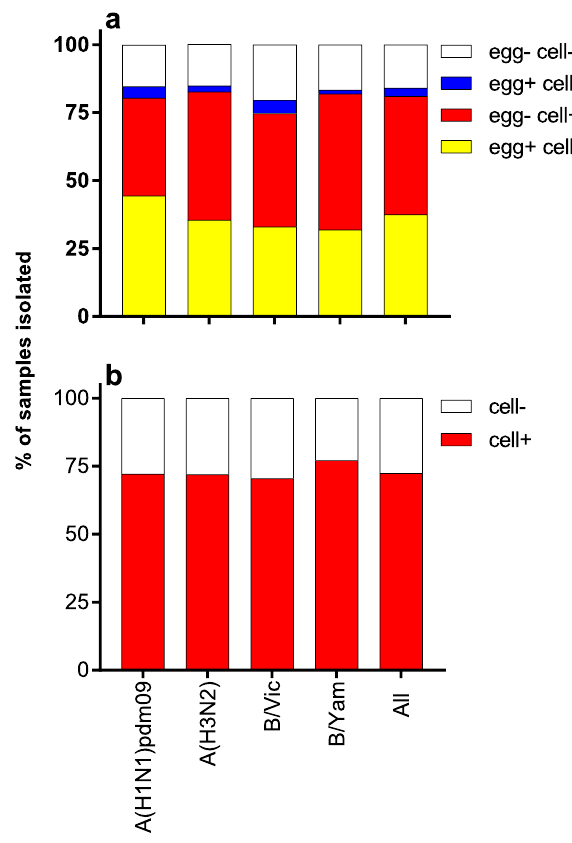
Fig. 1 The proportion recovery in each culture type of viruses grouped by subtype/lineage and of all samples combined. a 895 samples were inoculated into both cells and eggs and b 369 samples were inoculated into cells